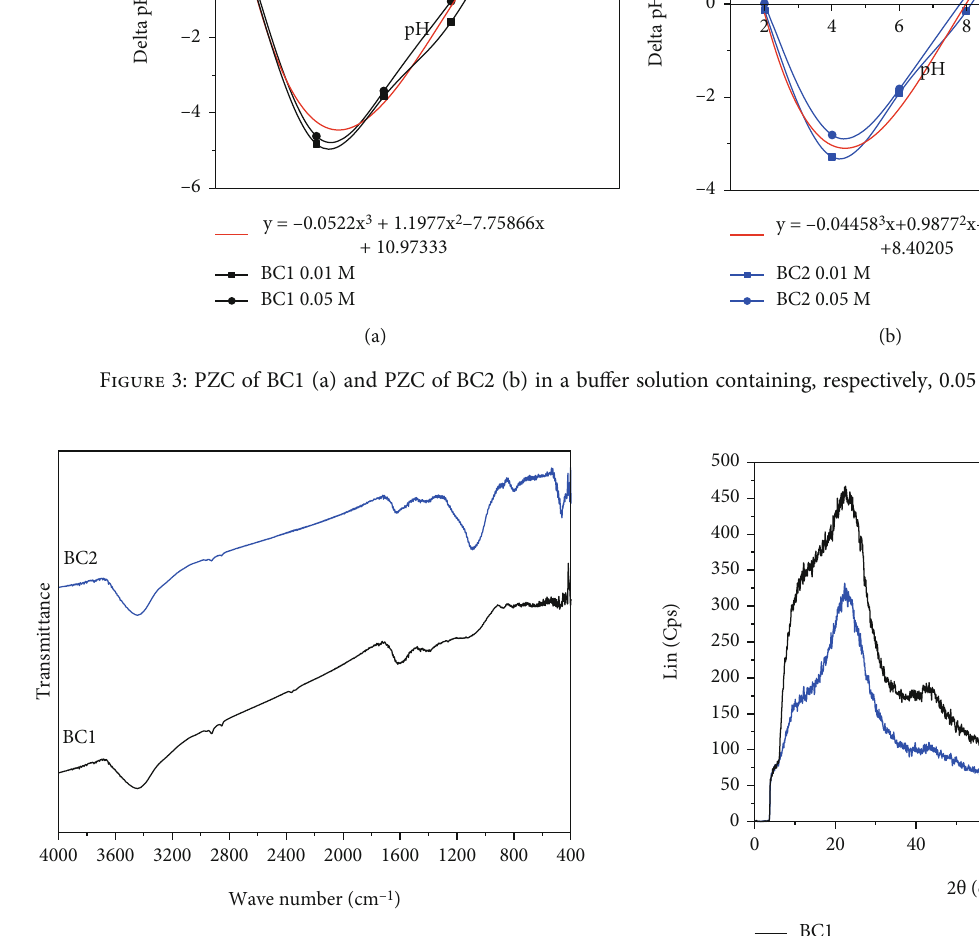
Figure 4: FTIR analysis on the biochar.